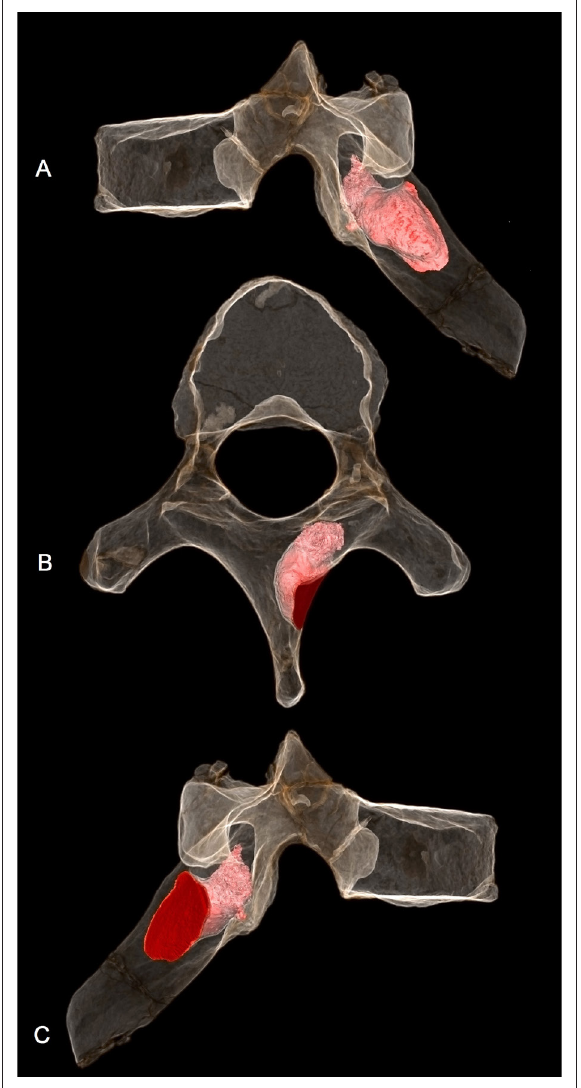
Figure 4: Vertebra U.W. 88-37. Sixth thoracic vertebra of juvenile Australopithecus sediba (Malapa Hominin 1). Partially trans- parent image volume with the segmented boundaries of the lesion rendered solid pink. Volume data derived from phase-contrast X-ray synchrotron microtomography. (a) left lateral view, (b) superior view, (c) right lateral view. Images produced by P.T.